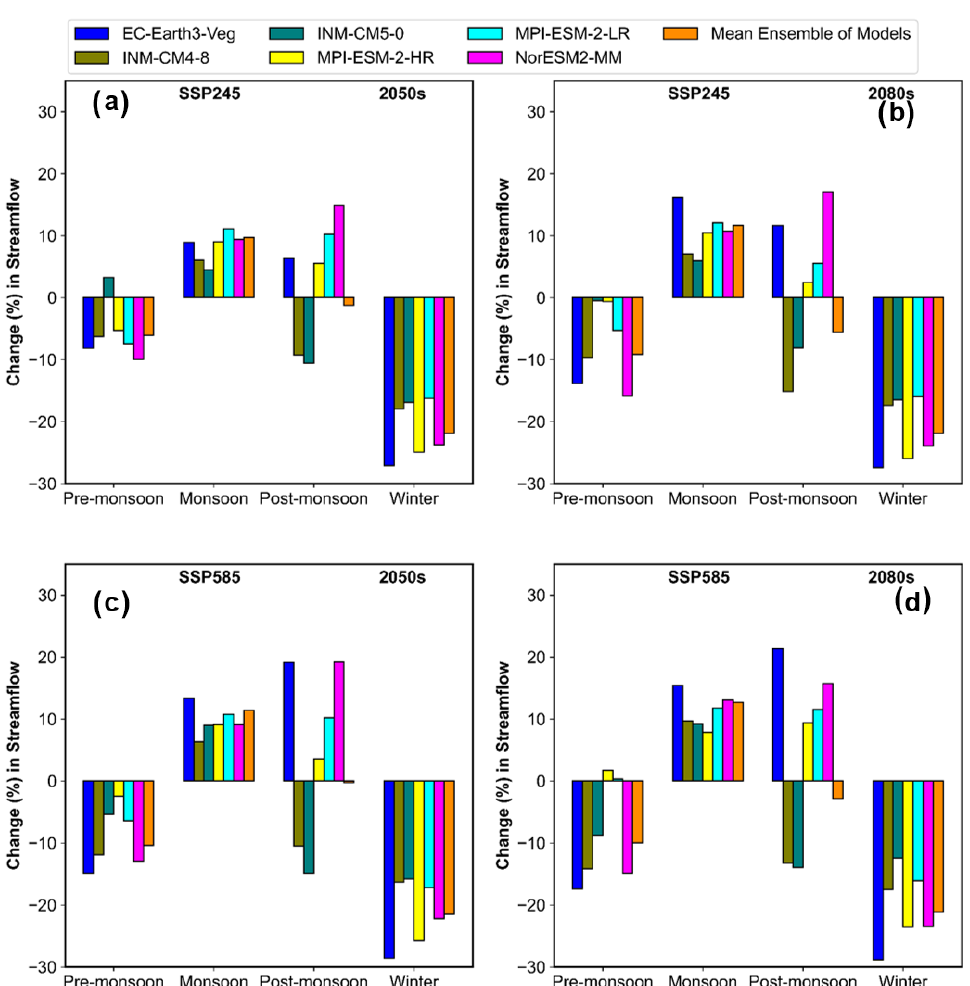
Figure 18. Predicted change in seasonal streamflow pattern of the Sutlej River with respect to the reference period (1979–2009) in the (a, c) 2050s and (b, d) 2080s under the SSP245 and SSP585 scenarios for different